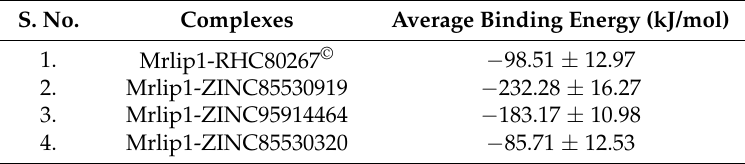
Table 6. Calculated MMPBSA binding energy between Mrlip1 lipase and their potential inhibitors. S. No. Complexes Average Binding Energy